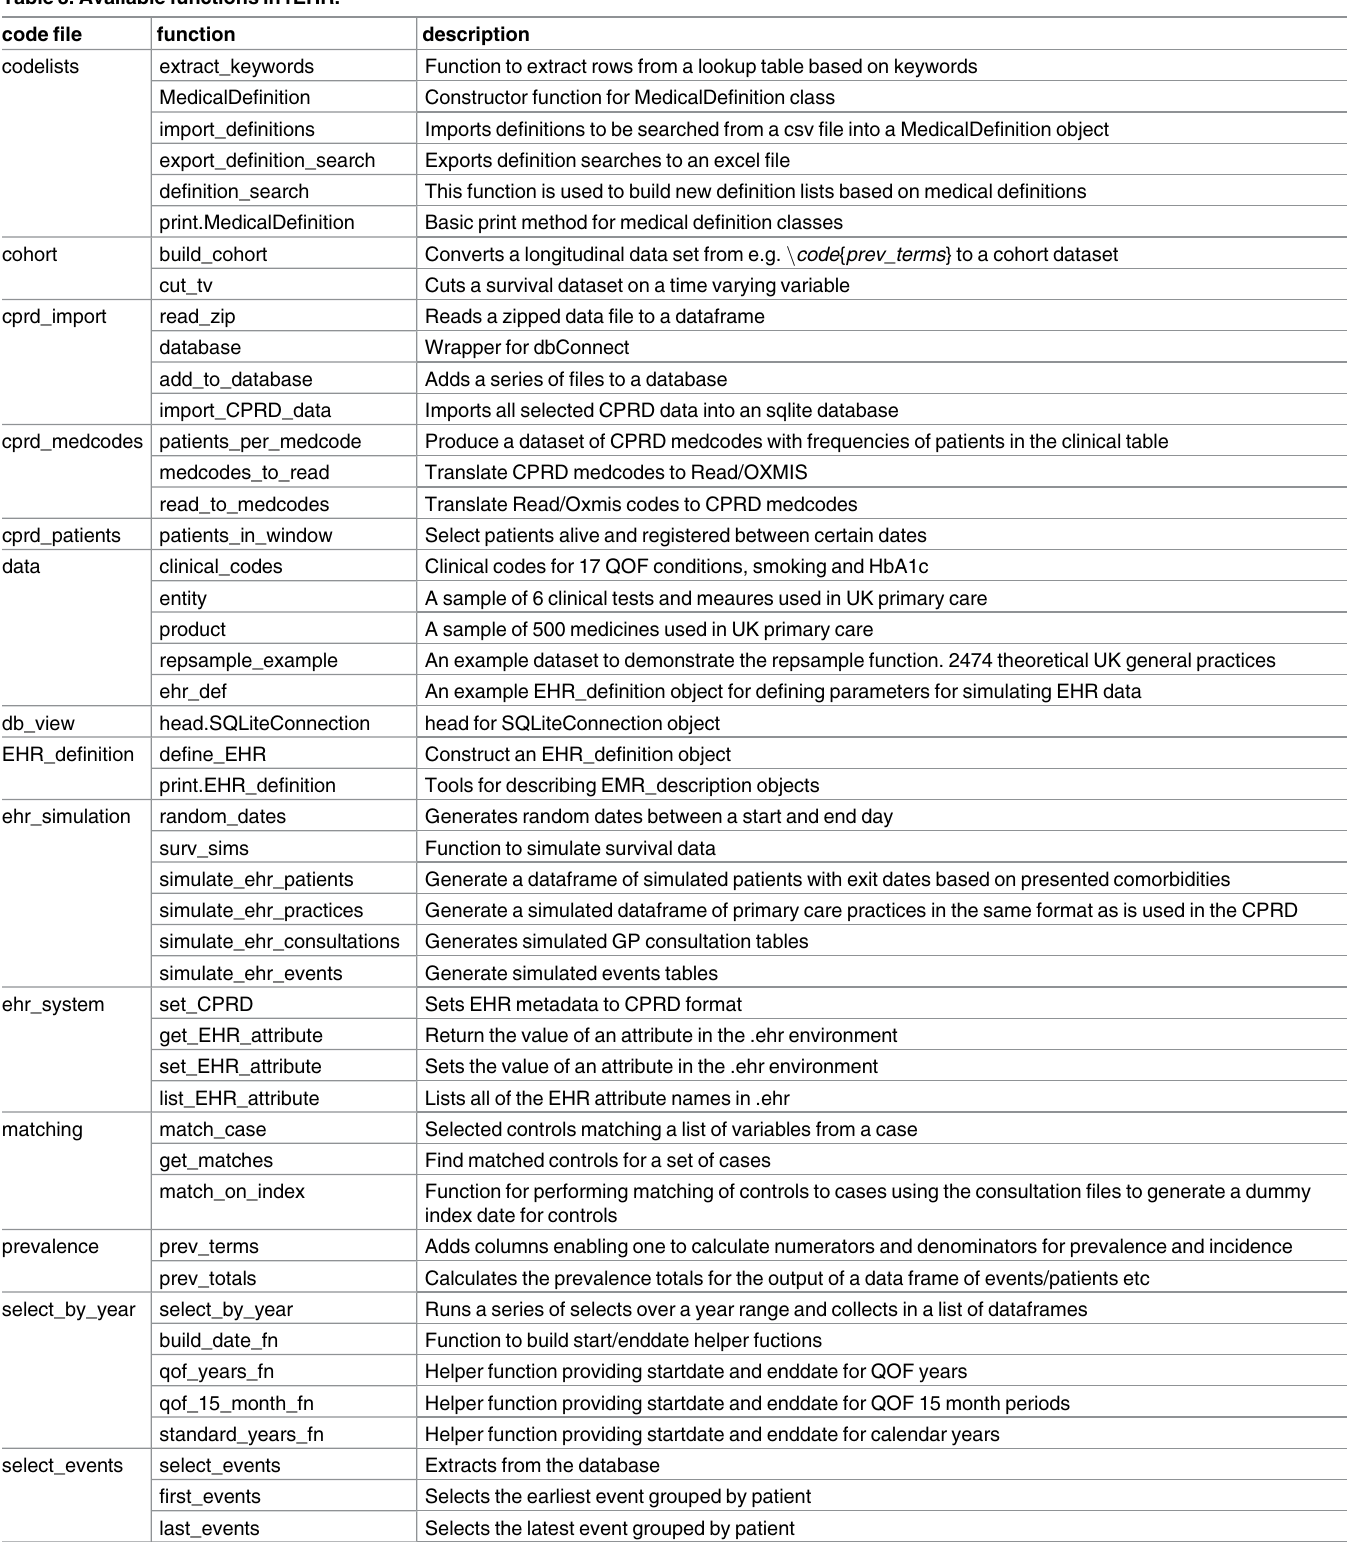
Table 3. Available functions in